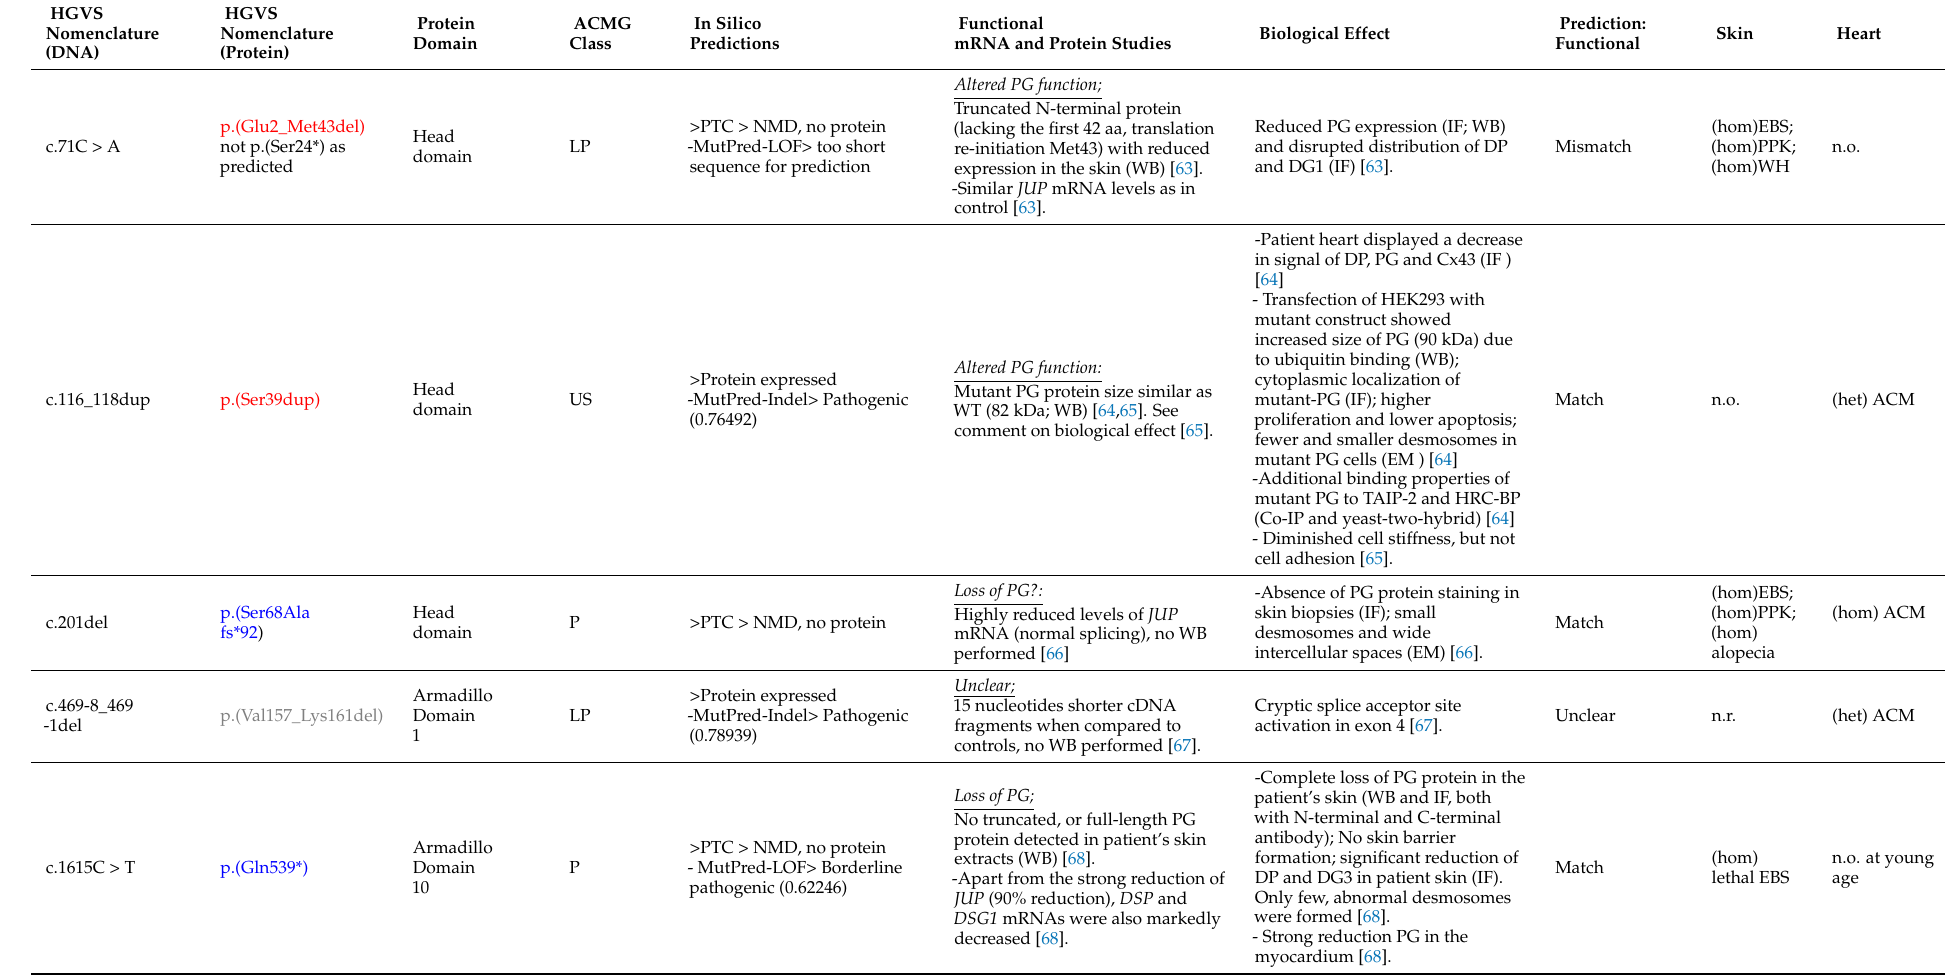
Table 2. Experimental investigation of JUP